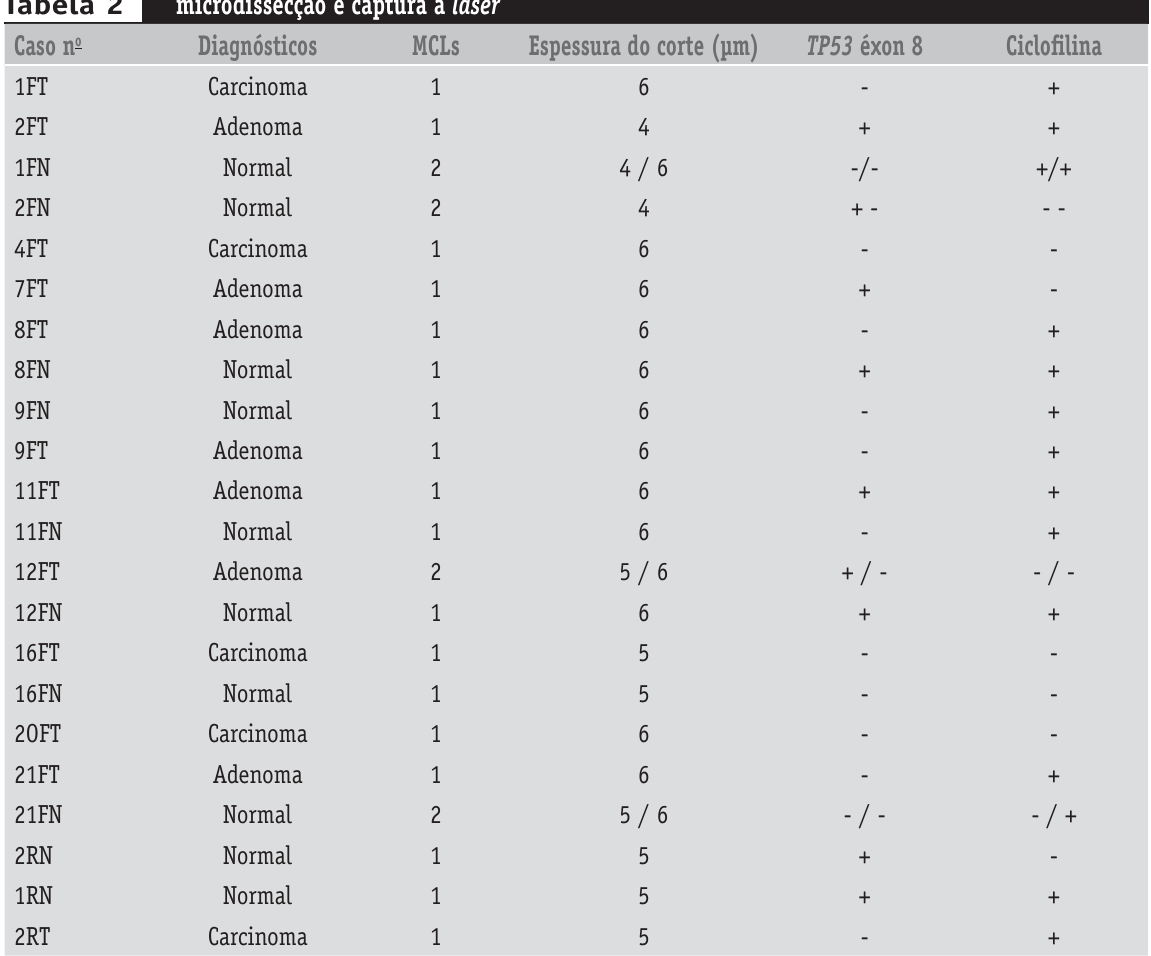
trados) foram os que apresentaram melhores